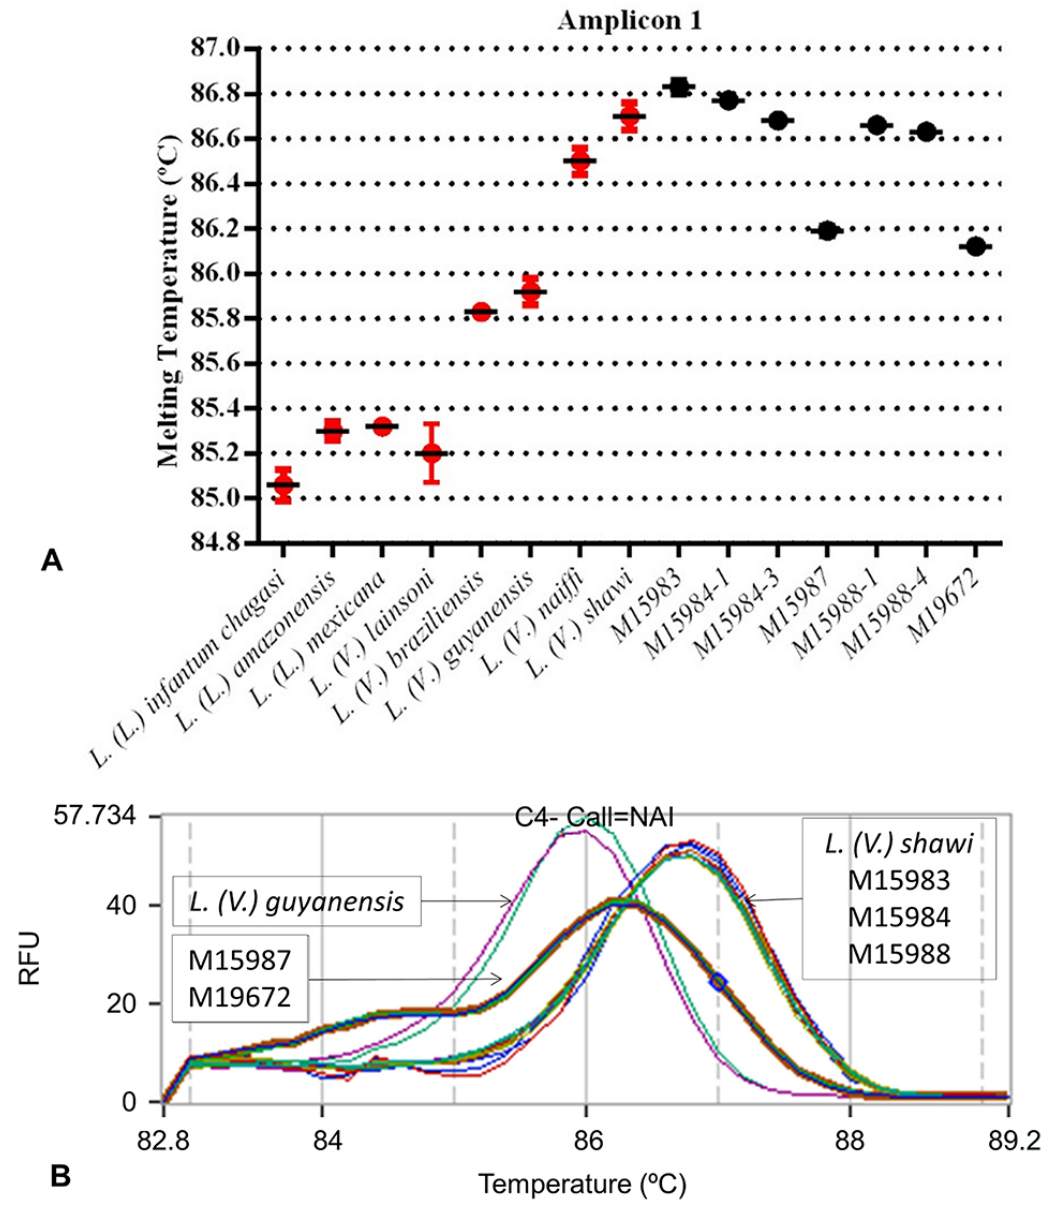
values. B -Normalized m